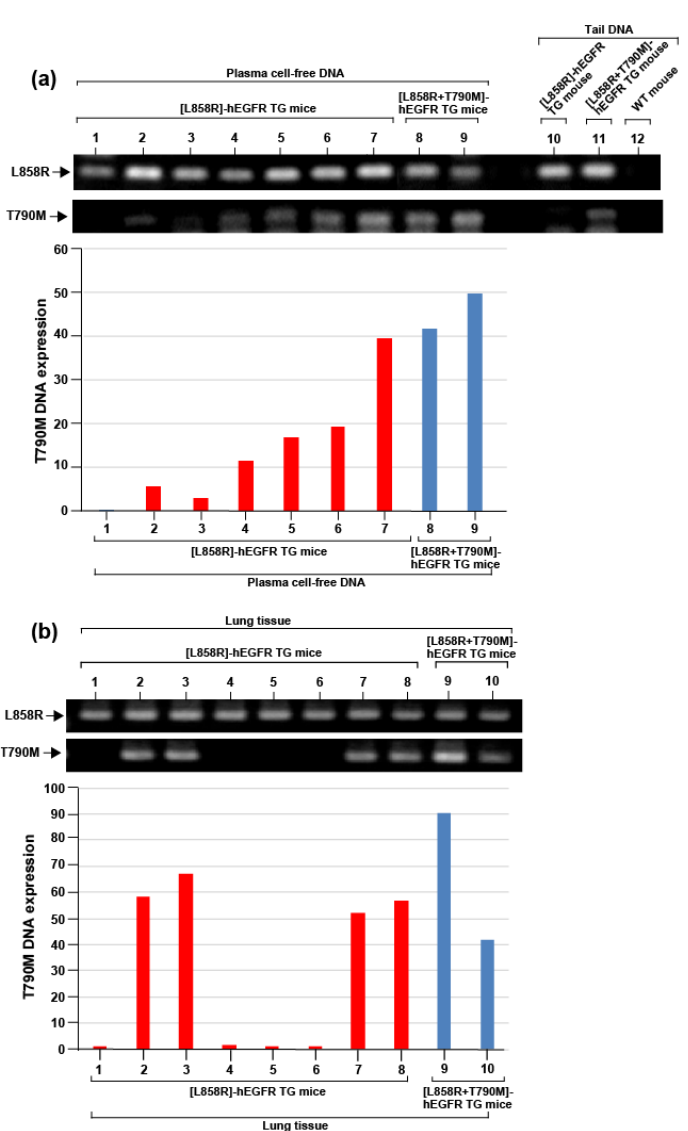
Figure 4. Acquired T790M mutant in [L858R]-hEGFR bitransgenic mouse lung tumor. PCR performed using plasma cell-free DNA ( a ) and lung tissue DNA ( b ) from [L858R]-hEGFR and [L858R+T790M]-hEGFR bitransgenic mice after several weeks of doxycycline administration.